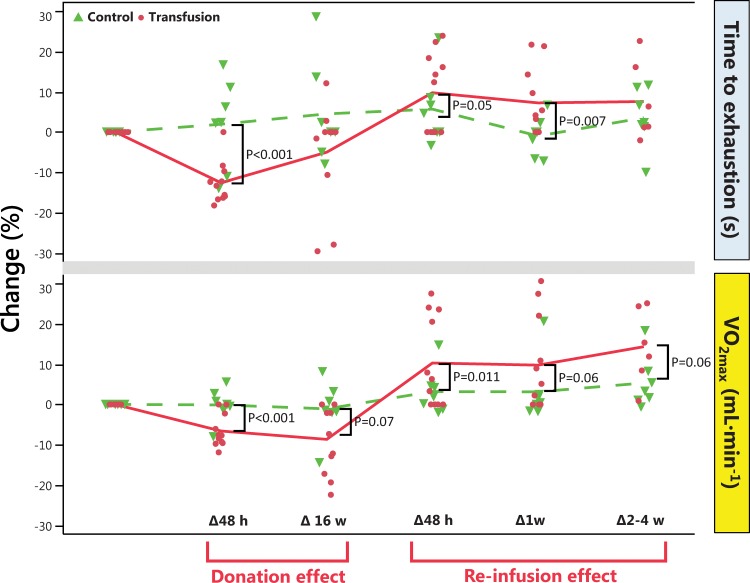
Change in performance and VO2max (mL·min-1) with blood donation and RBC re-infusion in Part A of the Study.Data is presented as percent change from baseline, with a line connecting means. The graph shows the effects of blood donation and RBC re-infusion on repeated testing for time to exhaustion and VO2max in the Transfusion group, and changes over time with repeated testing only in the Control group. For effects of blood donation baseline was set to Week 0, and changes in data on VO2max and time to exhaustion calculated to 48 h and 16 weeks after donation. For effects of RBC re-infusion baseline was set to Week 16. MANOVA demonstrated a difference over time between groups, and differences between groups at each time point (oneway ANOVA, p<0.1) are indicated by brackets. Changes at week seven is not shown, and results from tests weeks 19–21 collated. Control as dashed line (-—-), Transfusion as solid line (—). Difference between groups over time investigated by repeated measures MANOVA was significant (F = 12, p-value by Greenhouse-Geisser ε = 0.03), and one-way ANOVA at each time-point subsequently calculated.